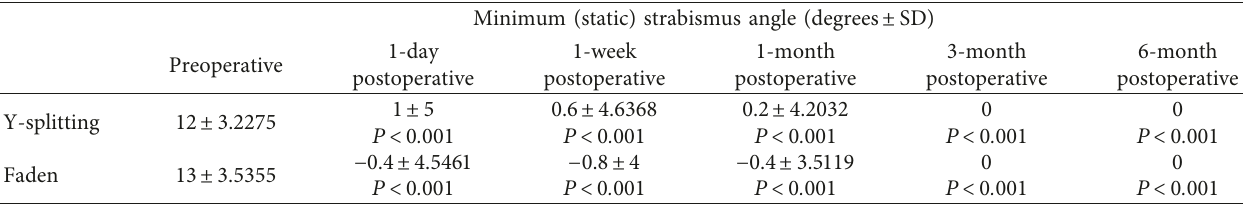
Table 2: The average values of the minimum strabismus angles preoperatively, one day; one week; one, three, and six months postoperatively.